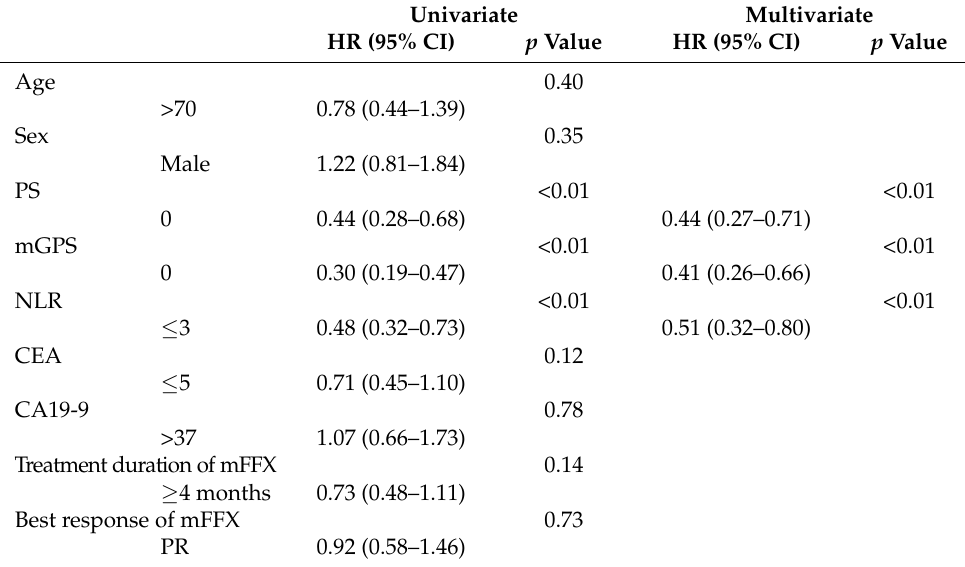
Table 4. Factors influencing overall survival.